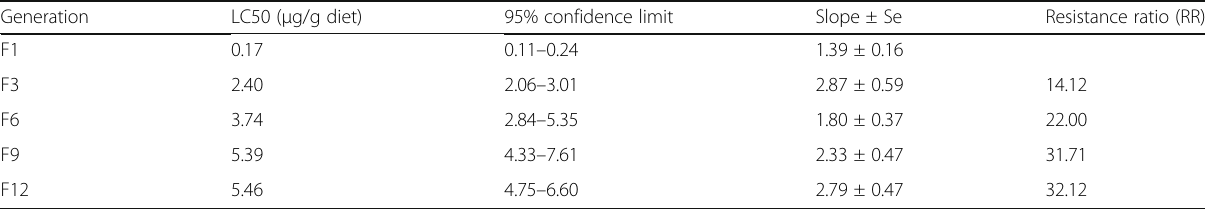
Table 1 Resistance development in Spodoptera littoralis laboratory selected line against Cry1C toxin